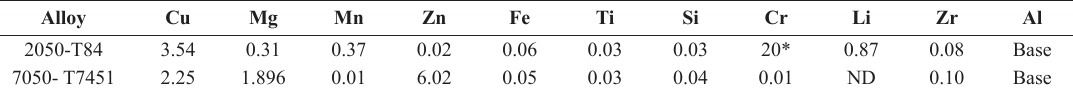
Table 1. Nominal chemical composition of the Al alloys (wt%). Alloy